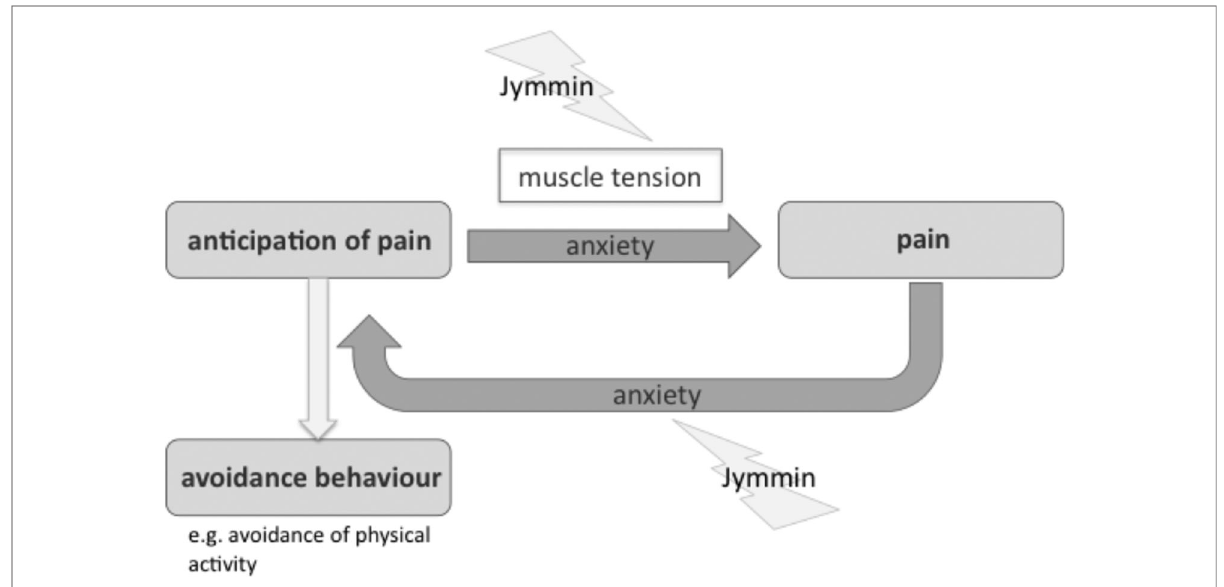
FIGURE 7 In fl uence of Jymmin on the Anxiety Loop of Pain. Disruptive effect of Jymmin on the depicted loop are indicated by the lightning